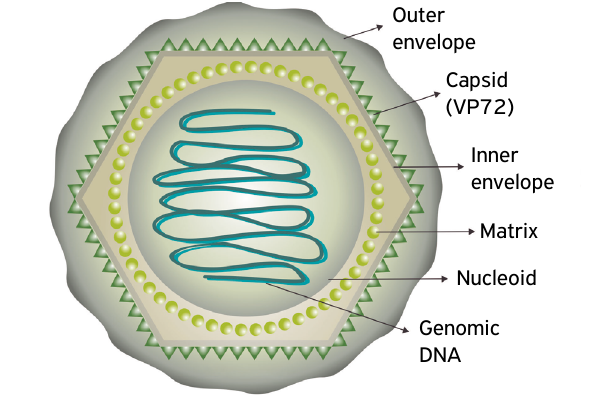
Figure 1. Schematic composition and structure of the African swine fever virus. Adapted from SALAS; ANDRÉS